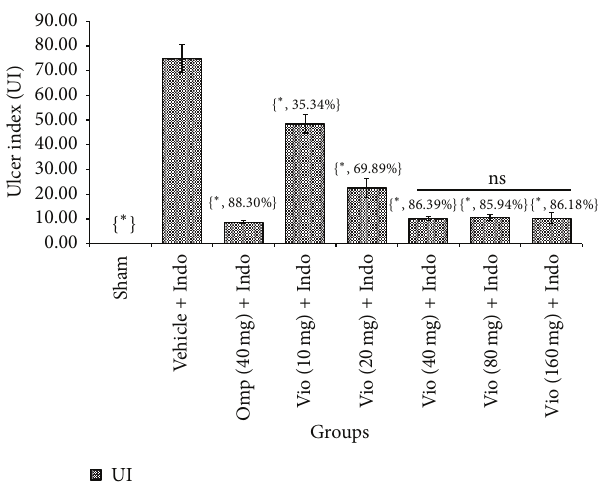
Figure 3: Effect of violacein (10, 20, 40, 80, and 160 mg/kg, orally) on indomethacin-induced ulcer index in rats. Values are mean ± SD ( 𝑛 = 6 ). ∗ 𝑃 < 0.05 compare vehicle + Indo with all the groups.